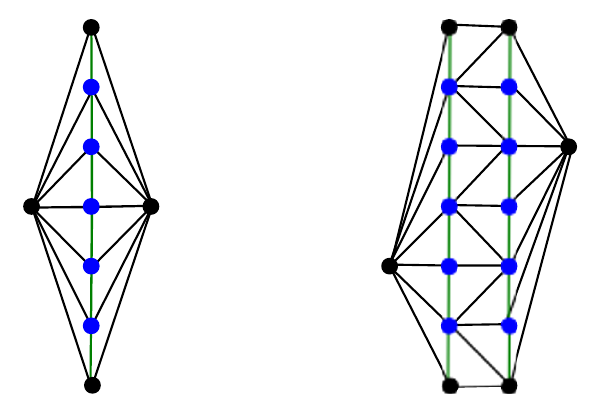
Figure 2 . The toric diagrams for SU( N ) k and SU( N ) N left the case of k = 0 for N = 6 is shown, on the right hand side k 1 = 1 = k 2 . In both diagrams we show a speci(cid:12)c full triangulation, i.e., the geometry in question is the fully resolved one, i.e., the theory on the Coulomb branch. The vertical green lines indicate the rulings that give the SU( N ) gauge